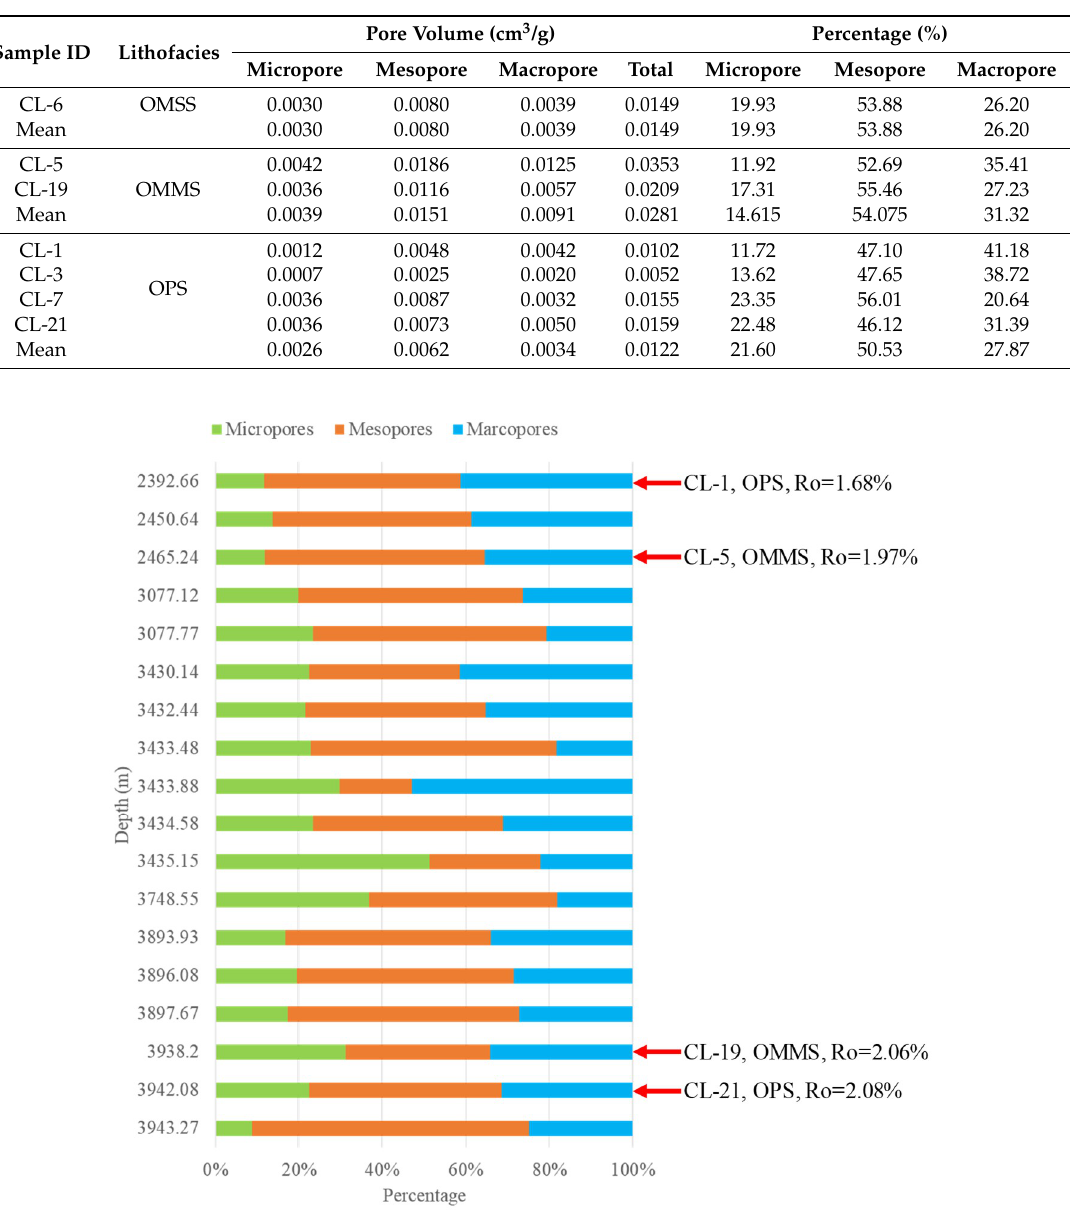
Figure 10. Percentage of pore volumes of the Shahezi shales along with depth in CFD.